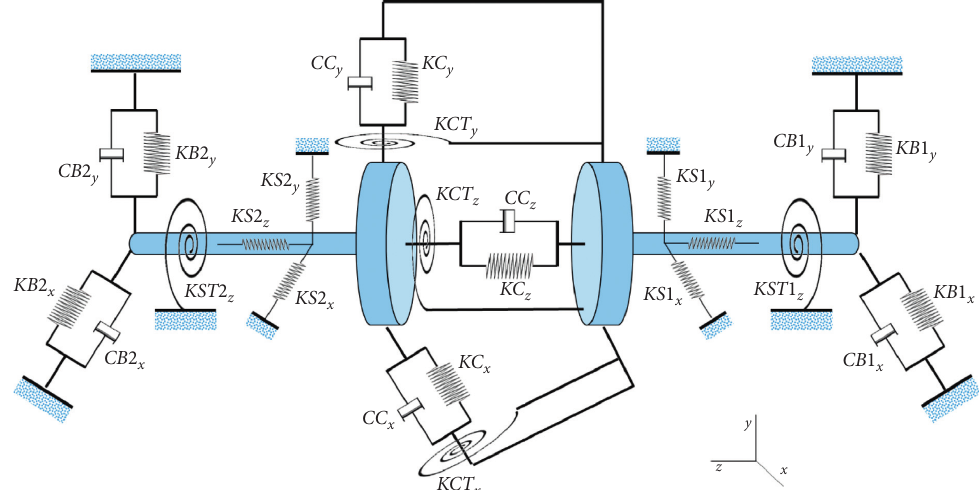
Figure 2: Multibody dynamic model of a rotating assembly (coupling+shafts+